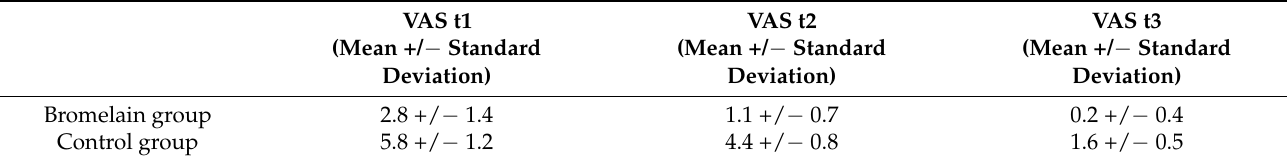
Table 2. Swelling score in test group and control group.